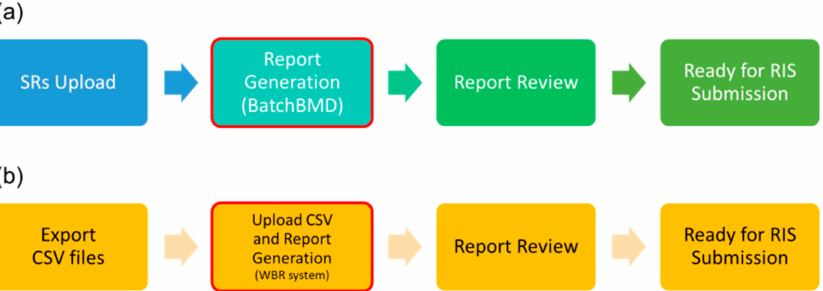
Figure 3. Reporting time computation. ( a ) The report flow for BatchBMD; ( b ) The report flow for a WBR